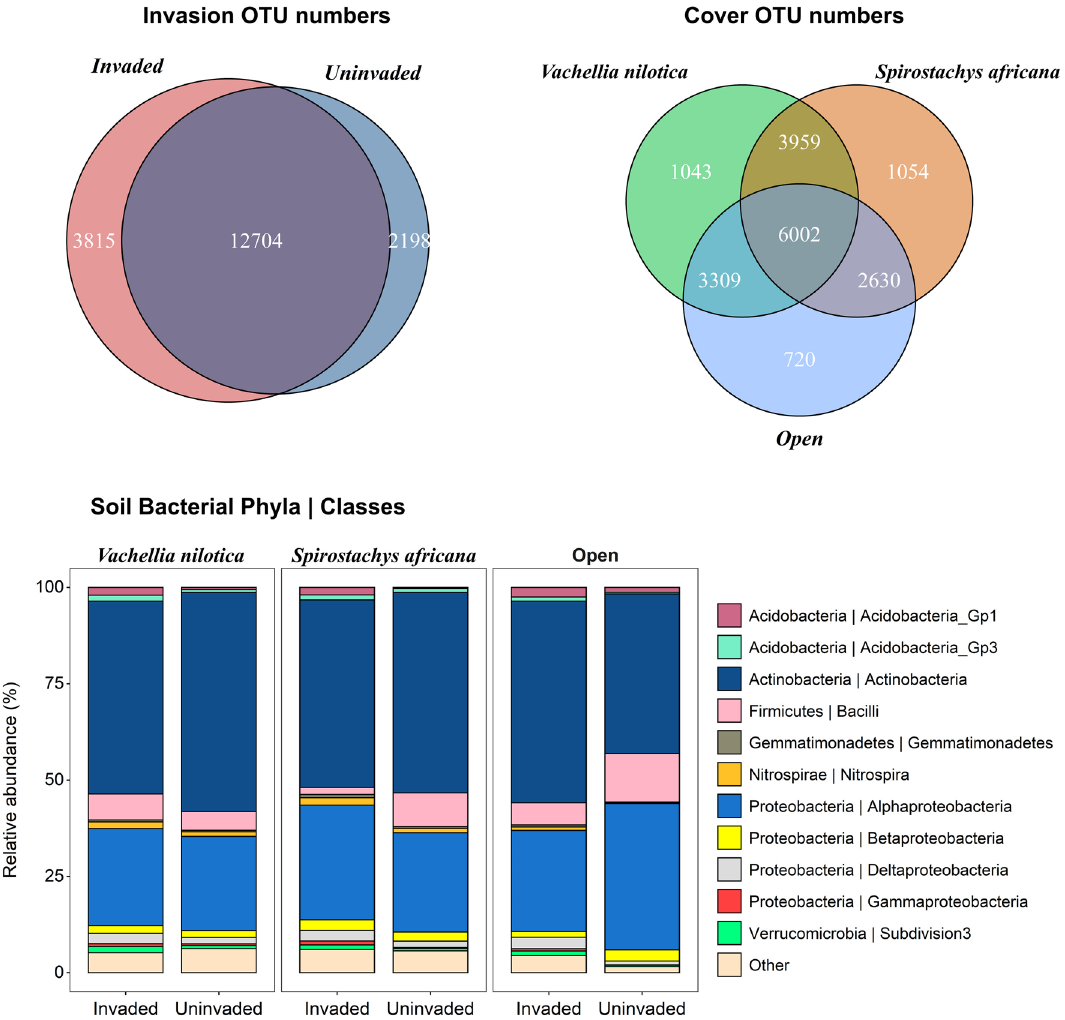
Figure 1. Distribution of OTUs (operational taxonomic units) between invasion (invaded and uninvaded; top left) and tree cover ( V. nilotica , S. africana , none; top right) categories, together with relative abundances of soil bacterial taxa (Class | Phylum). Class-level relative abundances were calculated using the number of sequences for each taxon as a percentage of the total sequences for each invasion/cover combination. The “Other” category includes taxa that were unclassified at Class level and classes representing less than 0.5% of the total number of